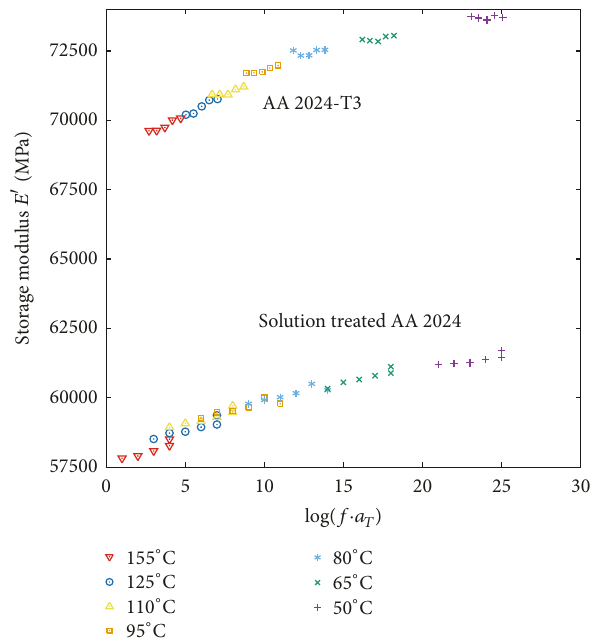
Figure 7: Master curve showing the storage modulus 𝐸 󸀠 versus the logarithm of the frequency 𝑓 times the shift factor 𝑎 𝑇 . These curves resulted from horizontal shifting of the isothermal 𝐸 󸀠 curves from DMA tests on AA 2024-T3 and solution treated AA 2024, at temperatures from 50 to 155 ∘